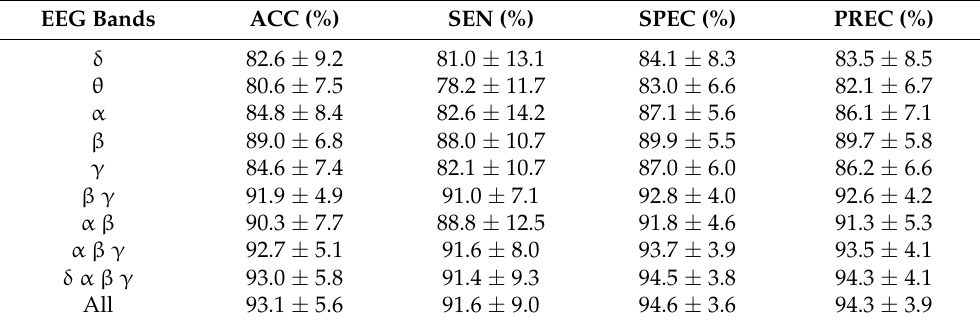
Table 5. Classification measures obtained for the second scenario, in which training and testing feature set vectors are from different